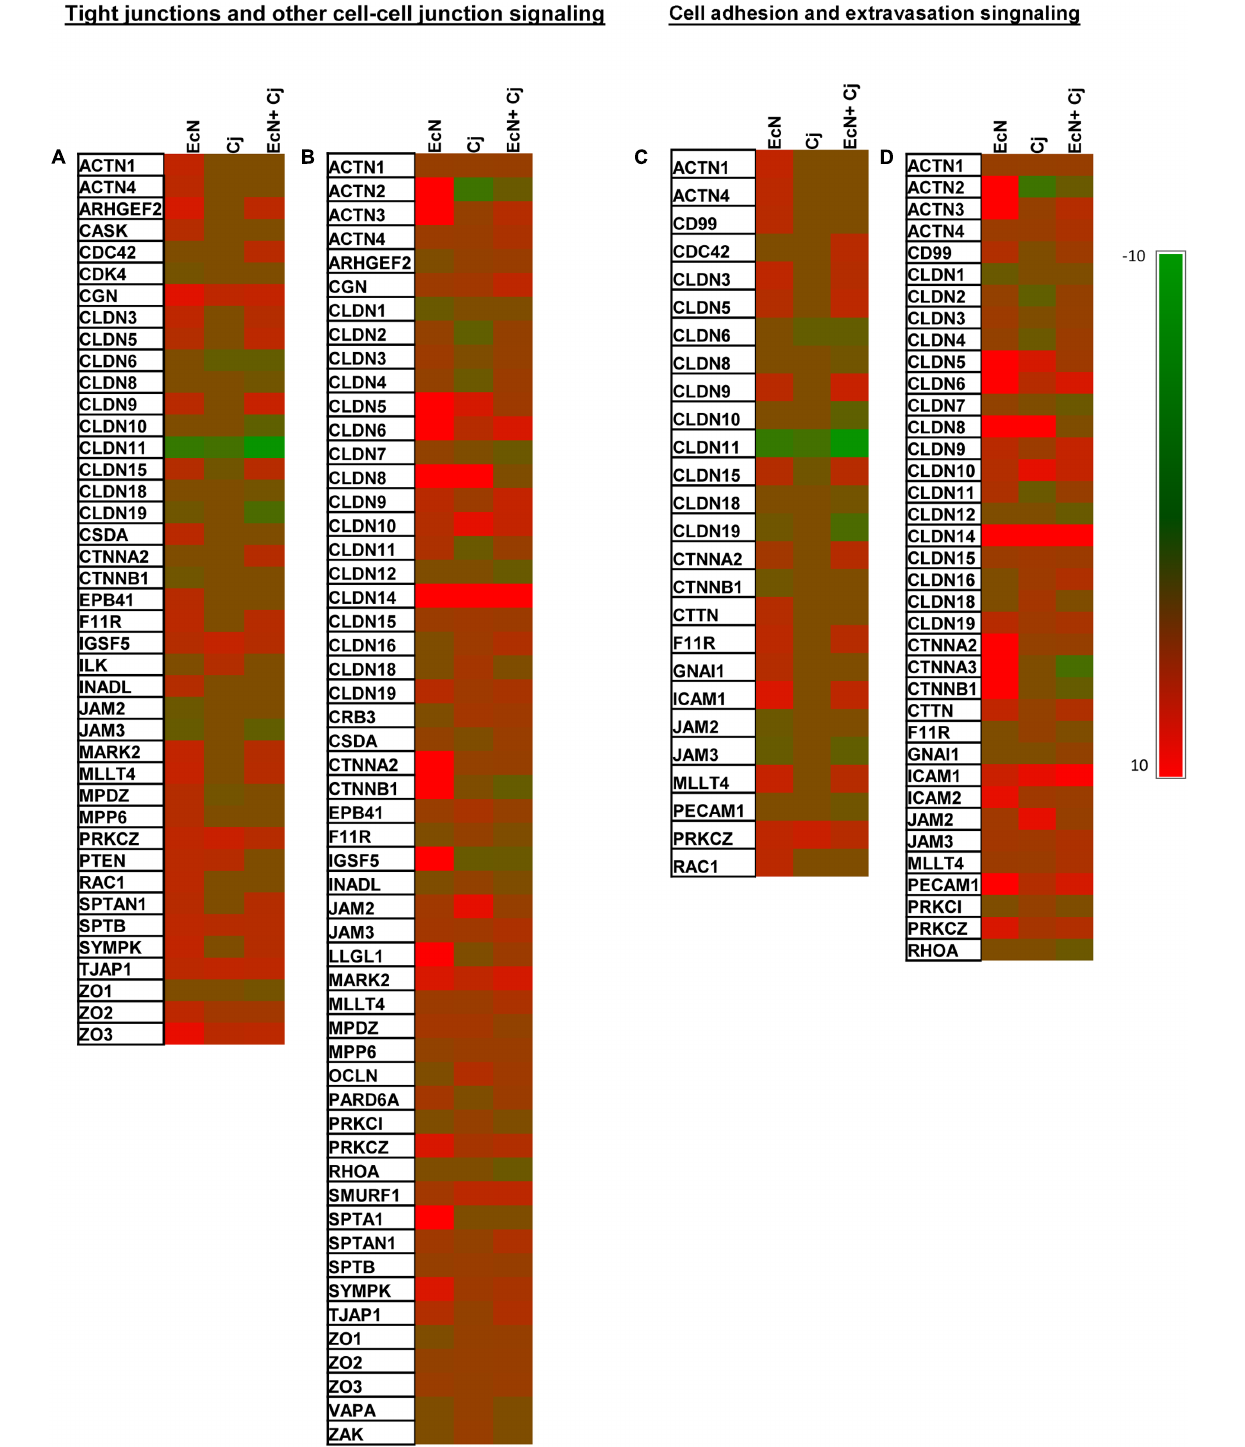
FIGURE 4 | Expression of tight junction associated genes in HT-29 cells with and without EcN and C. jejuni . Expression of genes associated with two significantly modulated canonical pathways (1) tight junction and other cell–cell junction signaling (TCS) at 2 h (A) and 24 h (B) C. jejuni post-infection and (2) cell adhesion and extravasation signaling (CAS) at 2 h (C) and 24 h (D) C. jejuni post-infection. The human tight junction RT 2 Profiler PCR arrays were used to assess the expression of 84 genes in EcN-pretreated cells at 2 and 24 h post- C. jejuni infection. Significant change in gene expression was determined by comparison to untreated cells (no EcN and no C. jejuni ). A fold change of ± 1.5 ≥ or ≤ 1.5 and a P ≤ 0.05 were used to determine significant differences in gene expression.